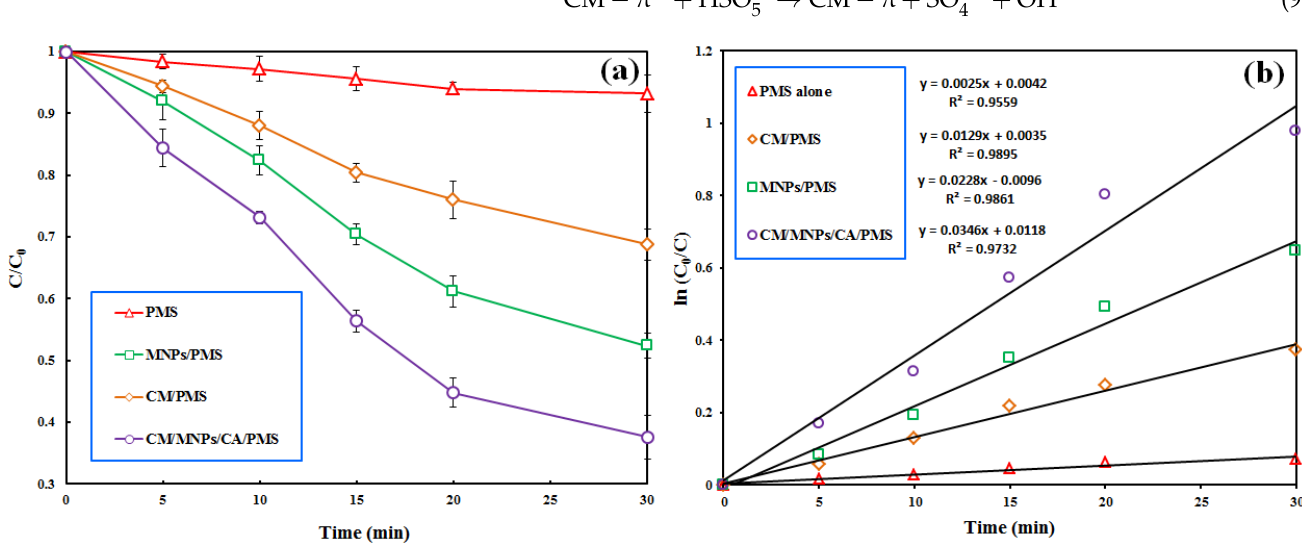
Figure 4. Effectiveness of various PMS-based treatment processes involved in the removal of IBP ( a ) accompanied with the results of pseudo-first order kinetic modeling ( b ). Experimental conditions: [IBP] 0 : 25 µM, catalyst dosage: 0.3 g/L, [PMS] 0 : 1 mM, reaction time: 30 min.